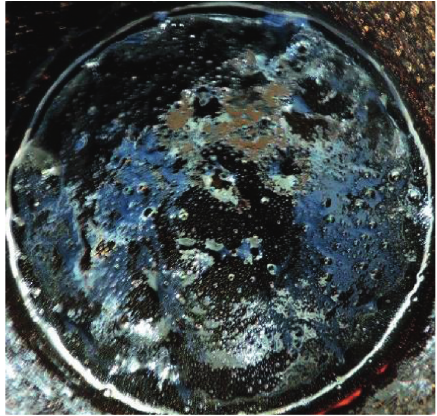
Figure 5: Foamy oil in the